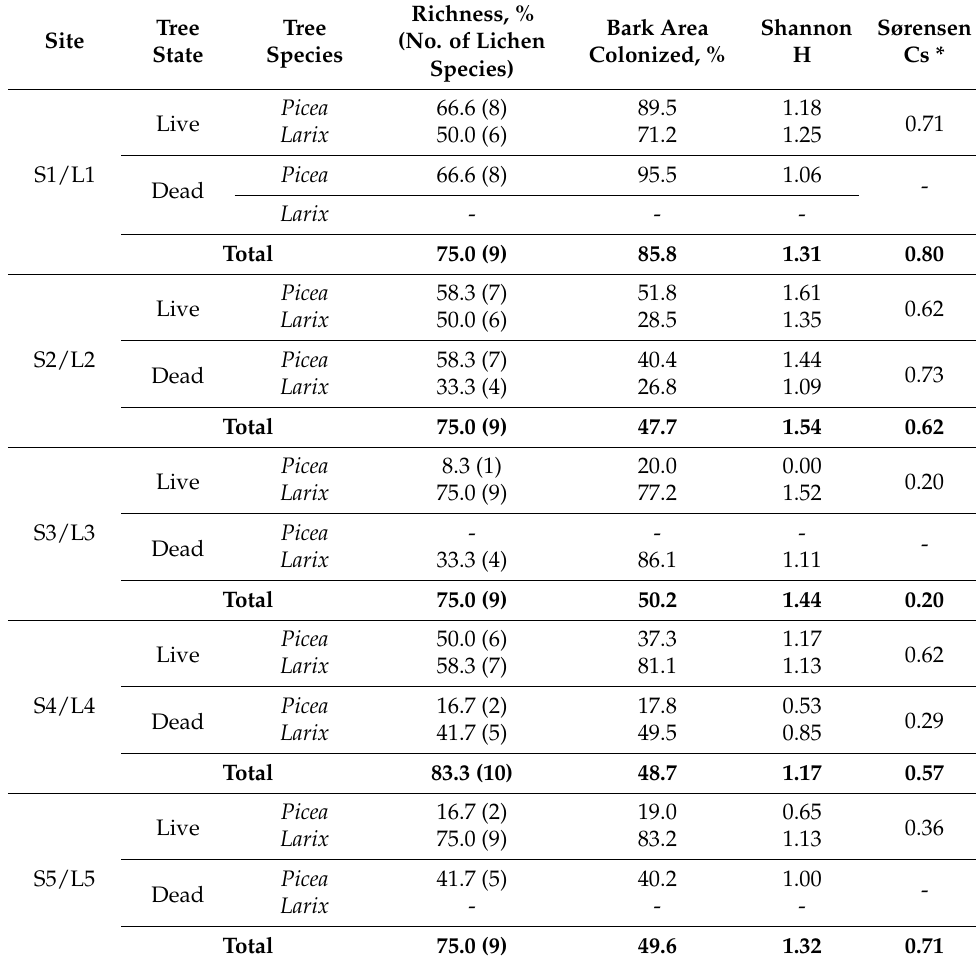
Table 6. Diversity and occurrence of epiphytic lichens on the bark of dead and living Picea abies and Larix sp.